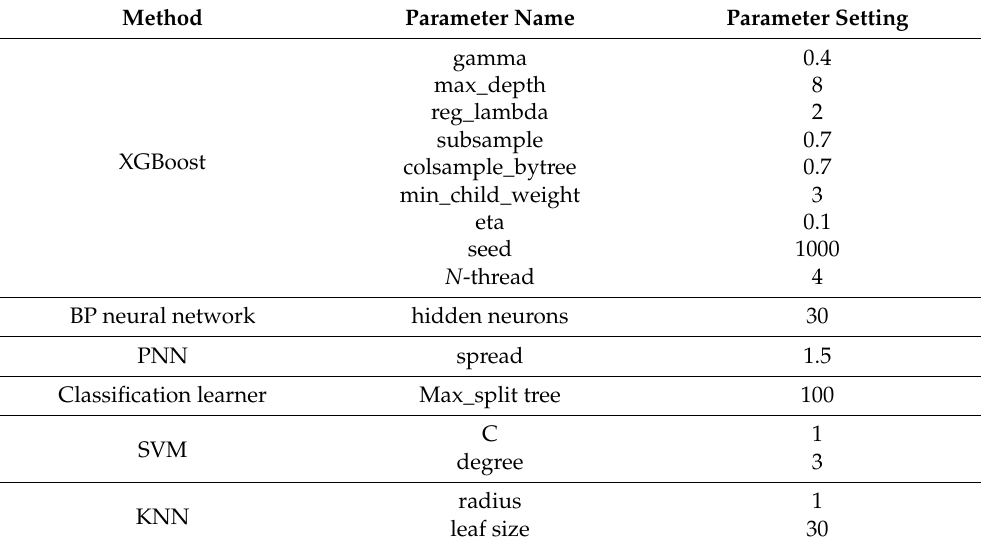
Table 4. Parameter settings of three